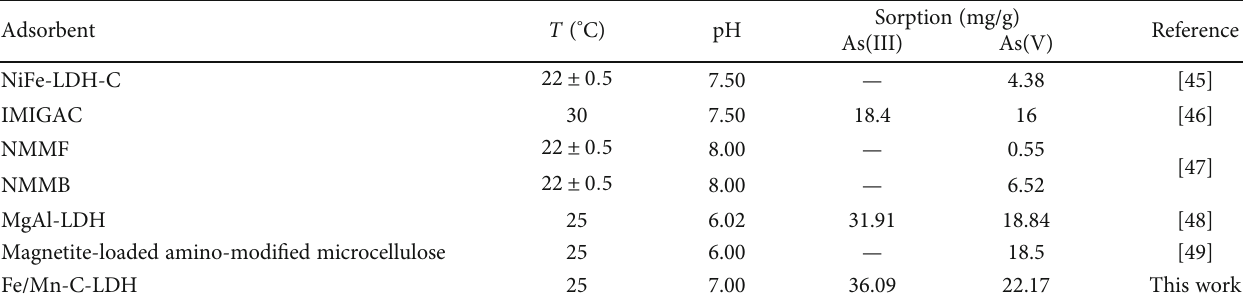
Table 6: Comparison among di ff erent adsorbent materials for removal As(III) and As(V) from aqueous solutions.